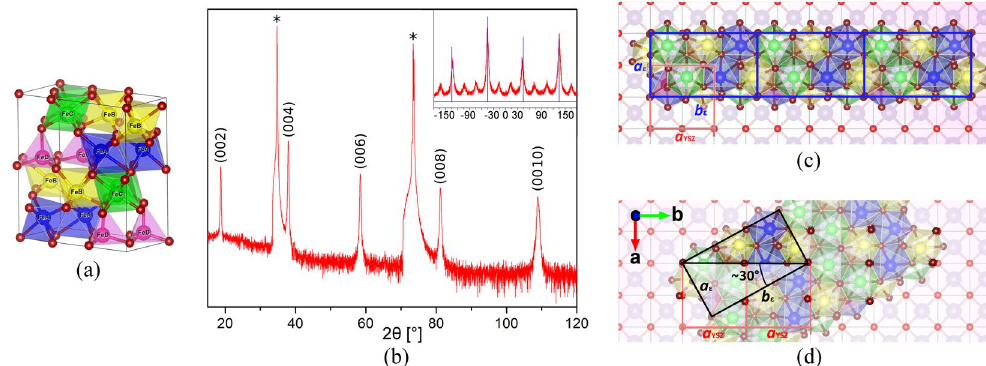
Figure 1. Graphic simulation of ( a ) ε -Fe 2 O 3 unit cell, ( c ) and ( d ) the two epitaxial matches between ε -Fe 2 O 3 (001) and YSZ (100) along with the directions of the lattice directions for YSZ. ( b ) X-ray θ /2 θ diffractogram of Epsilon Ferrite thin film grown on YSZ (100), confirming the epitaxial growth. The peaks noted by asterisk are the (100) and (200) peak of the YSZ substrate. In the inset, 360° Phi scan for the (013) peak of ε -Fe 2 O 3 (red line), along with the scan of the (220) peak of the substrate (blue), giving evidence of the formation of twinning in-